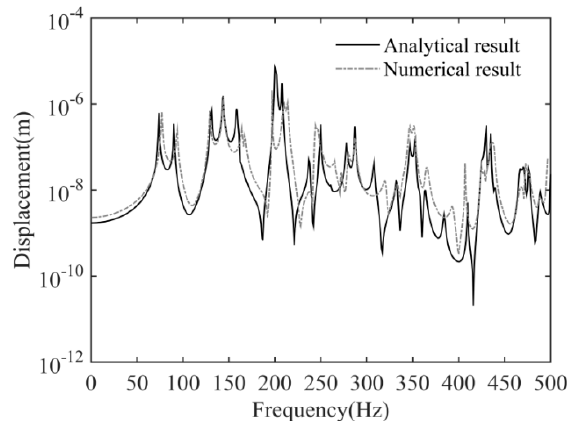
Figure 2. The displacement on the monitoring point of the ribbed plate B, calculated by analytical and numerical methods.